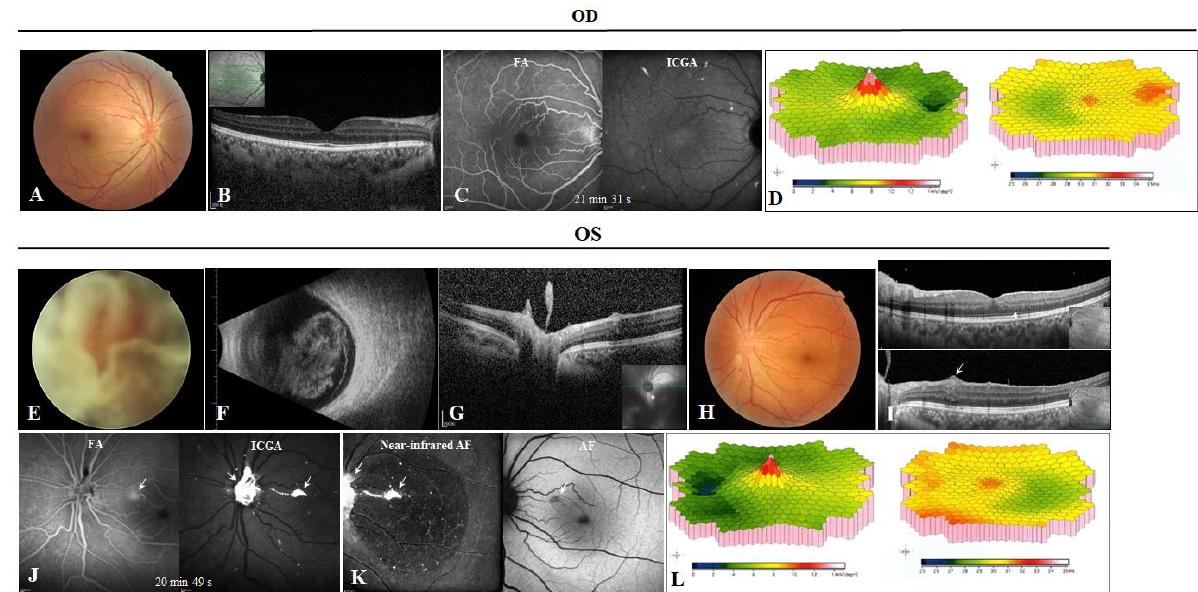
Figure 4. Case 3. ( A ) Fundus photograph of the right eye, showing tortuous veins. ( B ) Optical coherence tomography (OCT) image through the fovea of the right eye was mostly normal. ( E ) Pre- operative fundus photograph of the left eye, showing vitreous haze. ( F ) B-scan ultrasound of the left eye. ( G ) Preoperative OCT image showing deposits on the surface of the optic disc. ( H ) Post- operative fundus photograph of the left eye, showing tortuous veins. ( I ) Postoperative OCT image showing flattening of the foveola as well as deposits in the retina (white arrowhead) and around the superficial vessels (white arrow). ( C , J ) Fluorescein angiography (FA) of both eyes showed a branch of a leaking artery in the left eye, while indocyanine green angiography of both eyes showed multiple hypercyanescence in both eyes and strong staining of the optic disc and the leaking artery (on FA). ( K ) Near-infrared autofluorescence and autofluorescence of the left eye. ( D,L ) Multifocal electroretinography showed bilateral decreased amplitudes and prolonged implicit